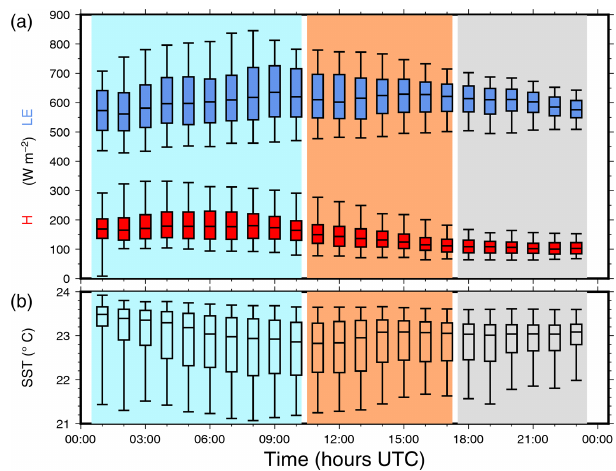
Figure 10. Time series of the median values of latent (blue) and sensible heat fluxes (red; a ) and of SST (b) in the EF600 area (see text) in the NOCPL run on 7 November. The boxes corresponds to the 25% and 75% quantiles and the whiskers to the 5% and 95% quantiles.